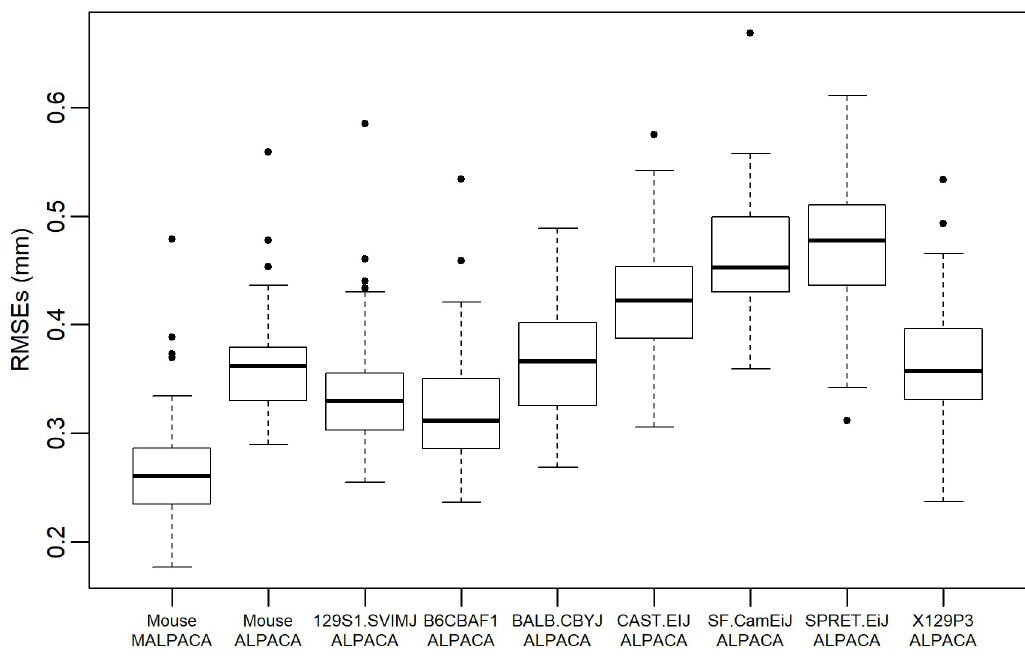
Fig 1. Comparison of RMSEs for the mouse sample. RMSEs calculated between estimated landmarks and the “gold standard”. Each box represents the RMSEs of 54 mouse specimens calculated by a specific analysis. “ALPACA”: Mouse ALPACA landmarks are estimated using the synthetic mouse template used in the original ALPACA paper. Other columns are ALPACA-derived estimates using each specified template. To see RMSEs expressed as percentage of specimen centroid sizes based on “Gold Standard” manual landmarks, please see S2